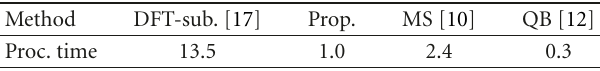
Table 1: Required processing-time normalized by the processing- time of the proposed